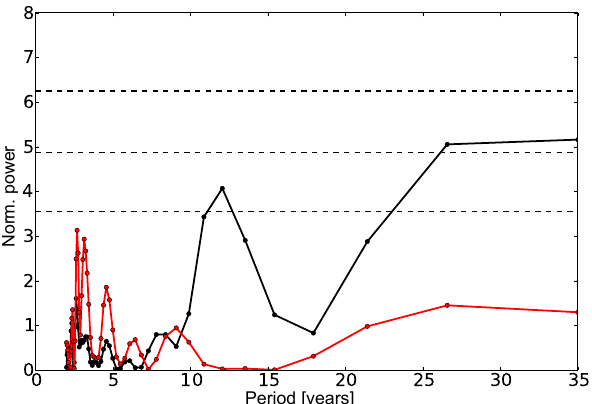
Figure 11. The Lomb–Scargle periodogram for the time series of annual OH ∗ temperatures (see Fig. 1 lower panel) is shown in black and the LPS for the residual after subtracting the fit according to Eq. (9) (see Fig. 10 lower panel) is shown in red. For details see description of Fig.